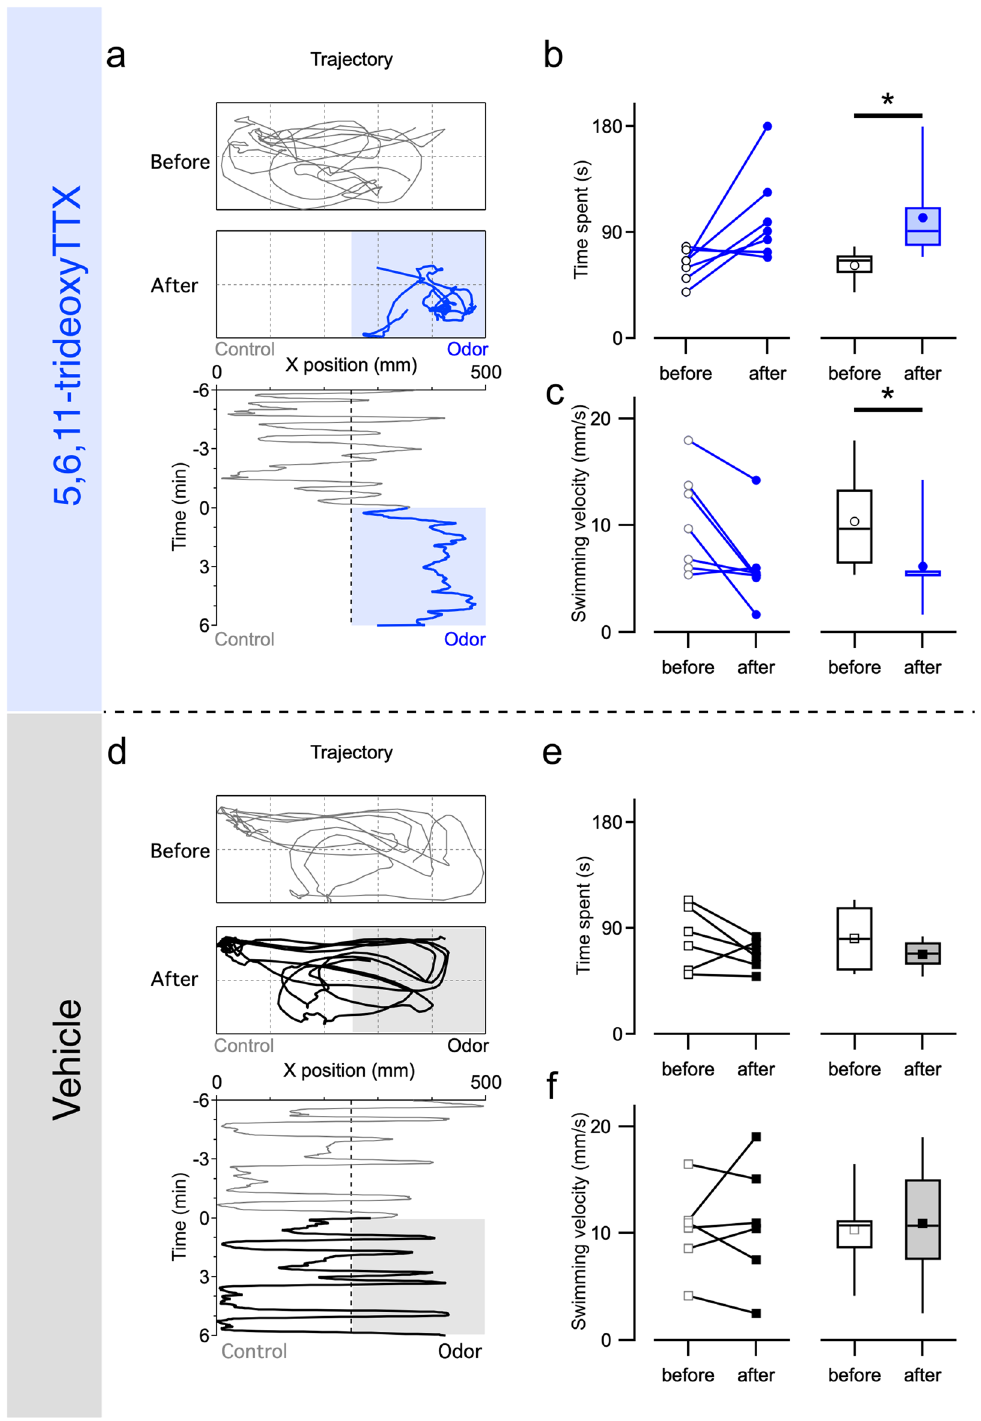
Figure 4. 5,6,11-trideoxyTTX attracts grass puffers. Tracked location of a grass puffer before and after 5,6,11-trideoxyTTX administration (5 mL of 10 –5 M dissolved in 2.5 × 10 –4 N acetic acid solution, Glid: 100 mm) and positions of the fish are plotted along the horizontal axis of the aquarium every 1 s. 5,6,11-trideoxyTTX was applied at time 0 and remained in the aquarium thereafter ( a ). Time spent on the administered side ( b ) and mean swimming velocity ( c ) during the 3-min periods before and after the 5,6,11-trideoxyTTX administration (n = 7). Paired t -test compared before and after the administrations. (Time spent, P = 0.037; Swimming velocity, P = 0.029). *p < 0.05. Tracked location of a grass puffer before and after vehicle administration (5 mL of 2.5 × 10 –4 N acetic acid solution, Glid: 100 mm) and positions of the fish are plotted along the horizontal axis of the aquarium every 1 s. Vehicle was applied at time 0 and remained in the aquarium thereafter ( d ). No significant changes in the time spent (3-min period) ( e ) or swimming velocity (mm/s; f ) in response to the vehicle administered on one side of the experimental aquarium (n = 6). Paired t -test compared before and after the administrations. (Time spent, P = 0.202; Swimming velocity, P = 0.728). Open or colored dots and boxes in the plot represent the data before and after odorant administrations. The line and scatter plots show the value from individual fish, and box plots show the median, quartiles (boxes), and 10–90% range